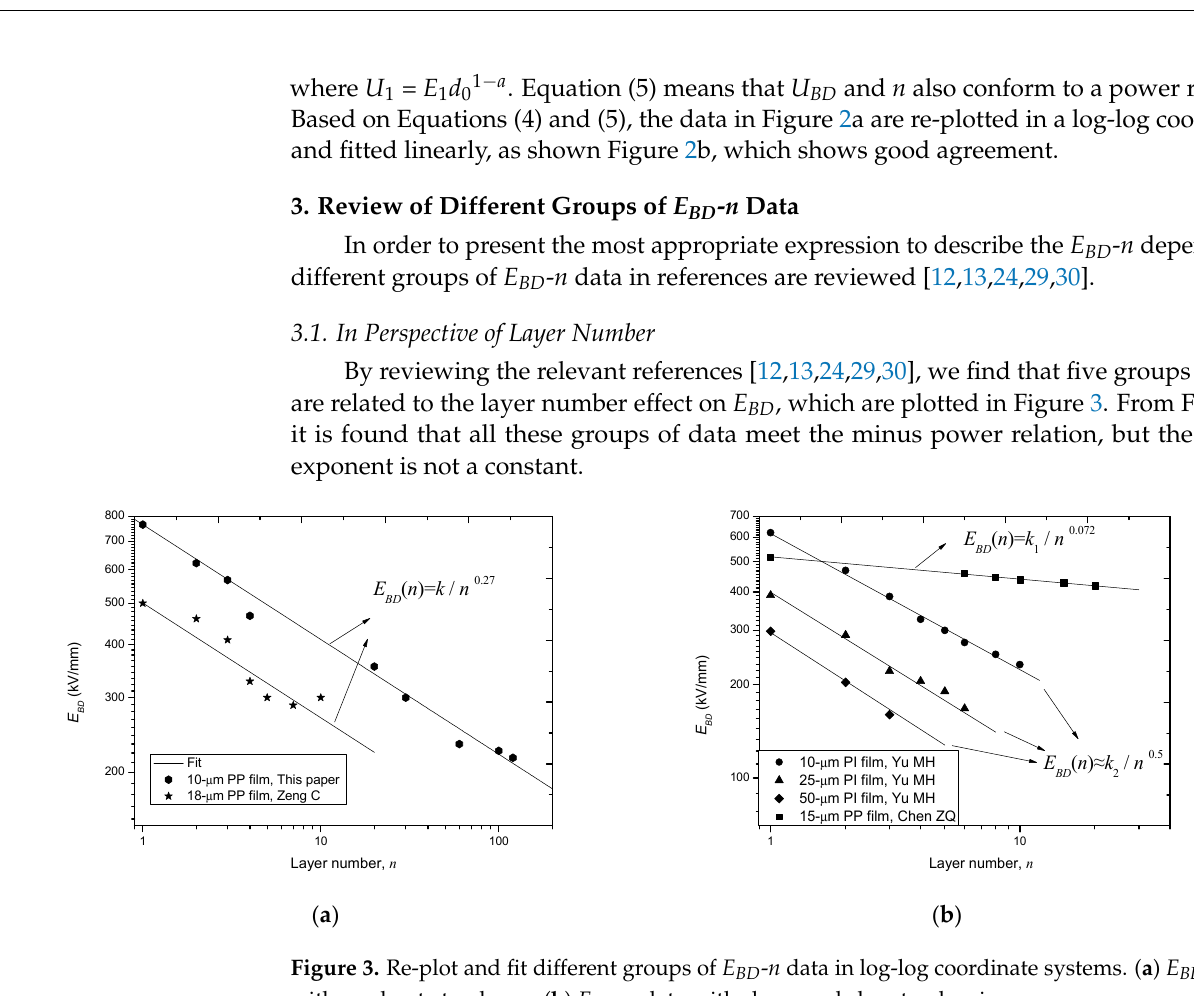
Figure 2. Experimental results of U BD and E BD dependent on d . ( a ) Raw experimental data; ( b ) fitted results in a log-log coordinate system.